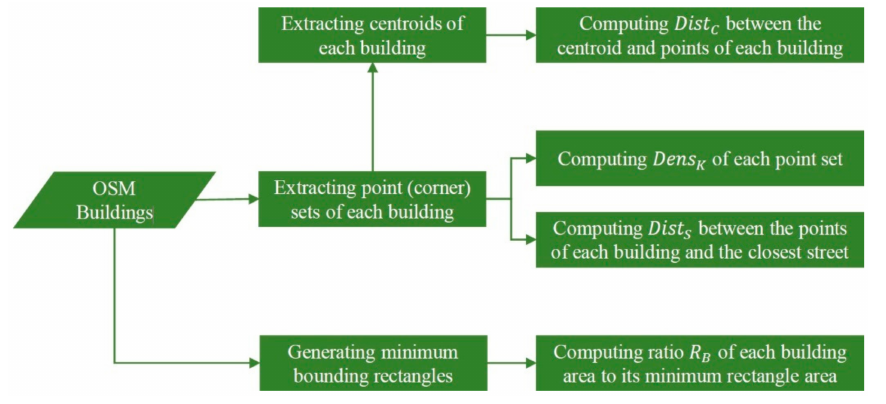
Figure 4. The computation schema of the